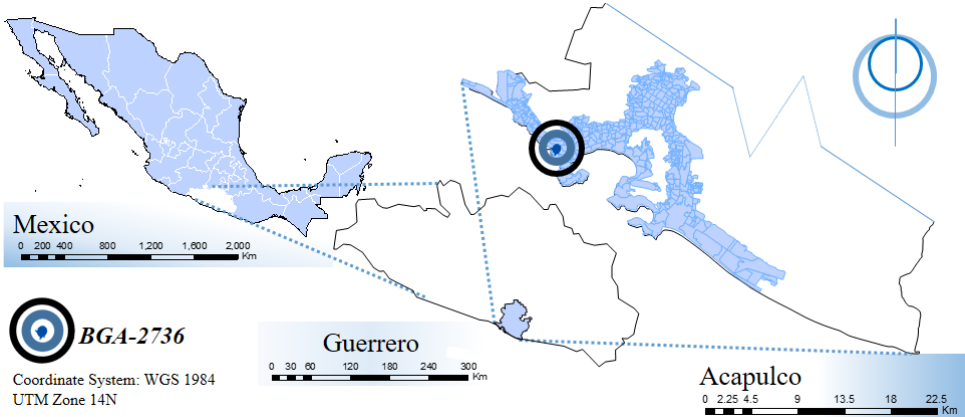
Figure 1. Basic geostatistical area 2736 location in Acapulco, Mexico.